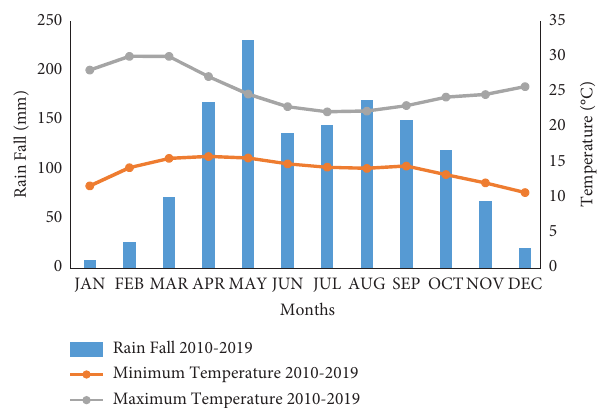
Figure 2: Ten years (2010–2019) monthly average rainfall and temperature data of Farawocha farm [18].